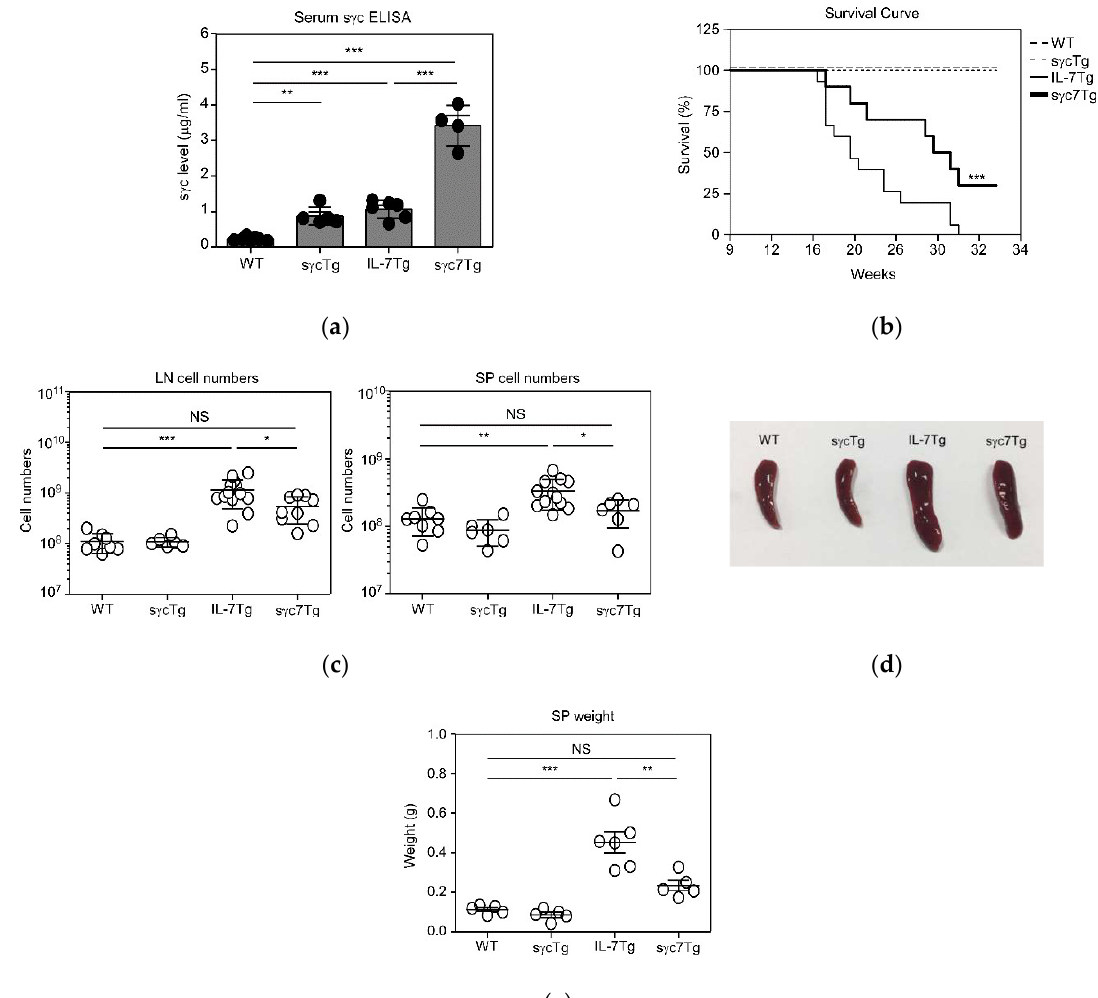
Figure 1. s γ c levels affect IL-7-induced mortality. s γ cTg mice were crossed with IL-7Tg mice and monitored weekly for lesions, node enlargement, and survival over eight months. ( a ) s γ c levels in wild-type (WT), s γ cTg, IL-7Tg, and s γ c7Tg serum were measured by ELISA. ( b ) Survival of WT ( n = 16), s γ cTg ( n = 14), IL-7Tg ( n = 15), and s γ c7Tg ( n = 10) mice were monitored every week. ( c ) Total lymph-node (LN) and spleen (SP) cell numbers in indicated mice. Each symbol represents an individual mouse. Horizontal lines indicate mean and SD. ( d ) Gross anatomy of spleens from the indicated mice. Picture shows representative spleen from n > 5 mice per group. ( e ) Summary of spleen weight from indicated mice. * p < 0.05, ** p < 0.01, *** p < 0.001, and NS mean not significant.